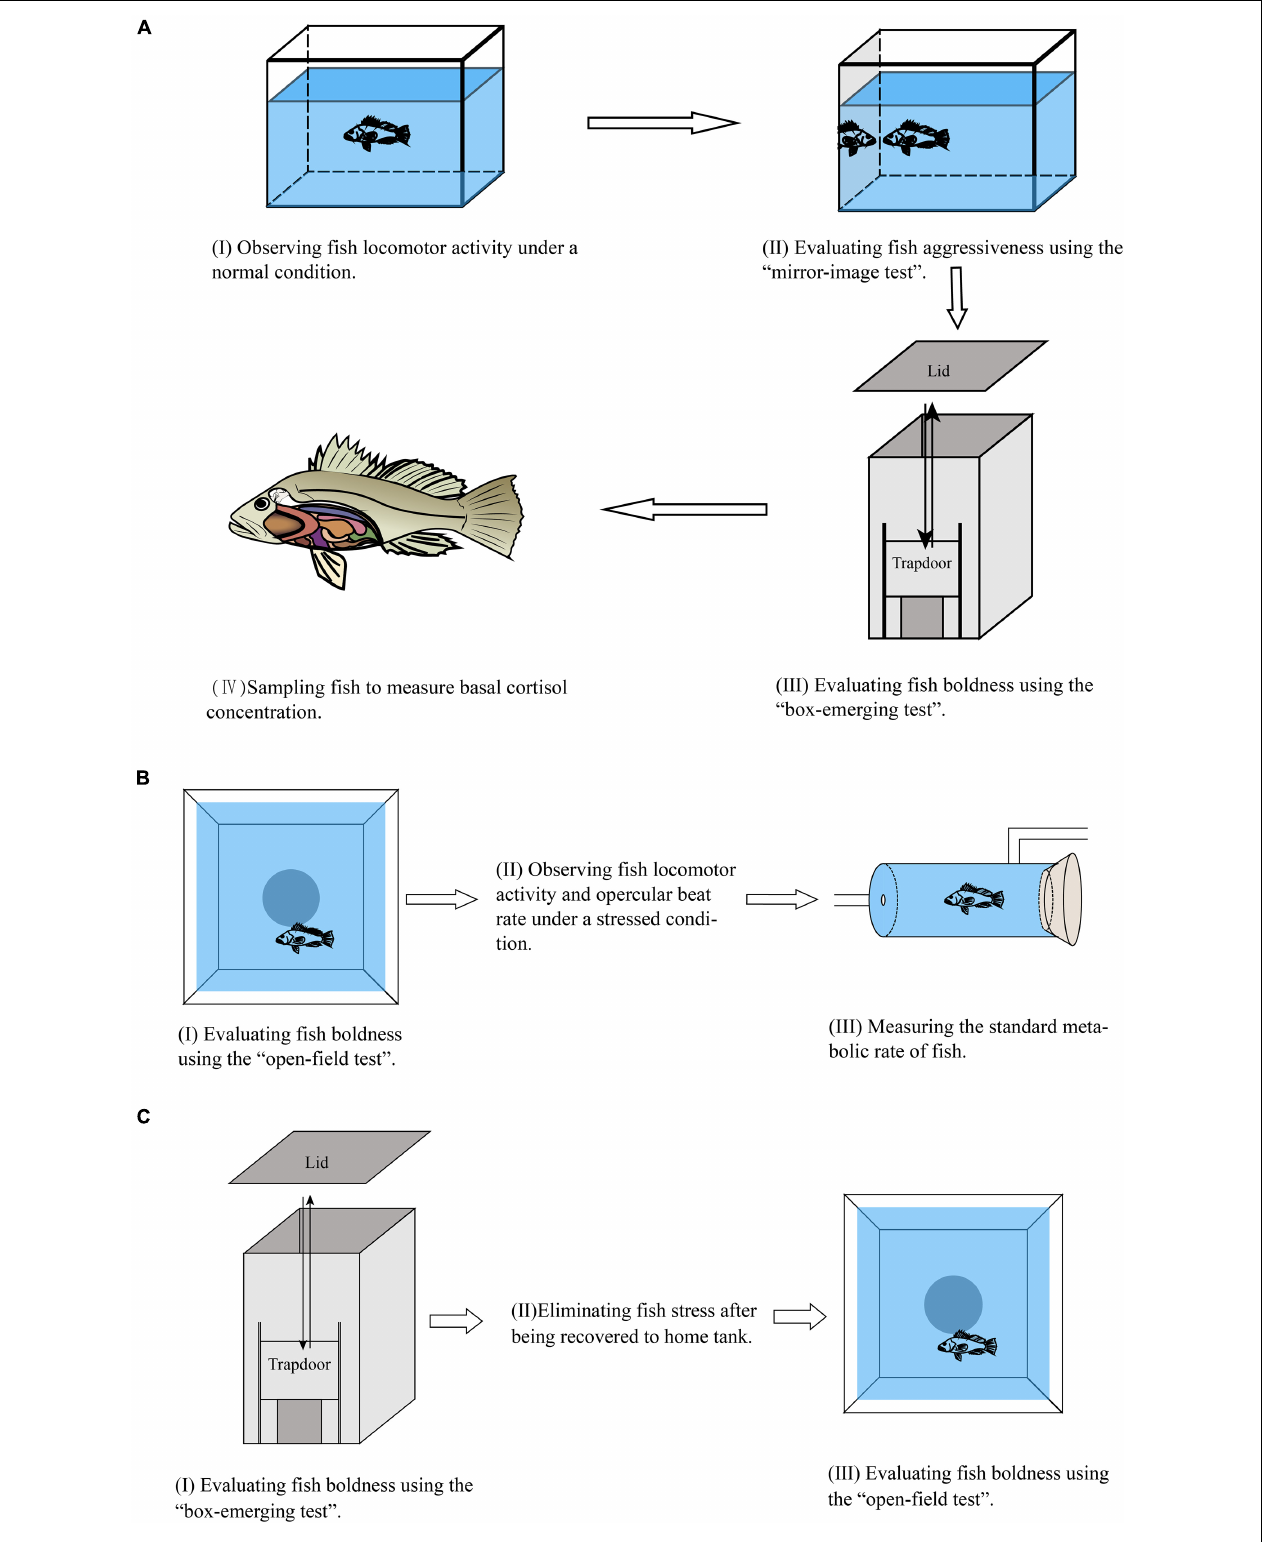
FIGURE 1 | The flow chart of the experimental design. (A) Experiment I. (B) Experiment II. (C) Experiment III.